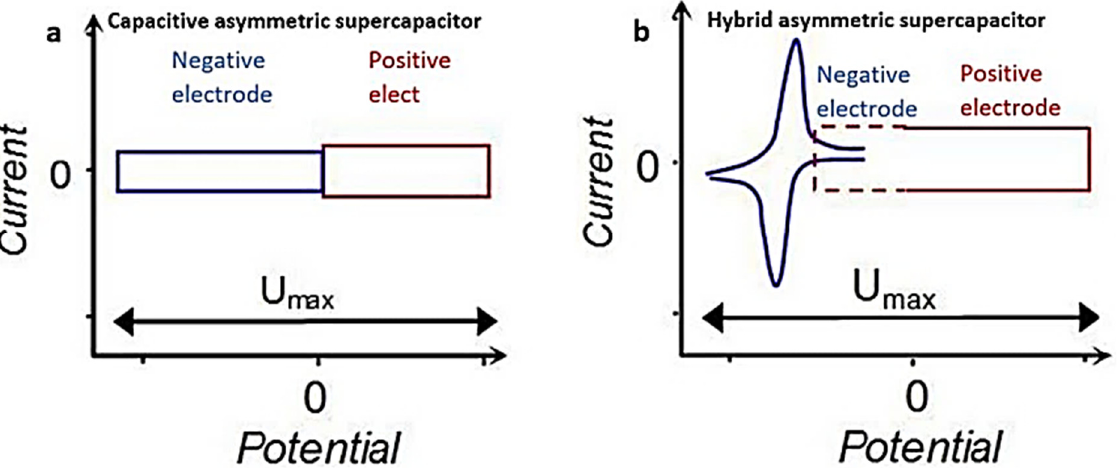
Figure 7. Schematic illustration of the CV curves for ( a ) capacitive asymmetric SC and ( b ) hybrid asymmetric SC [45], open access.